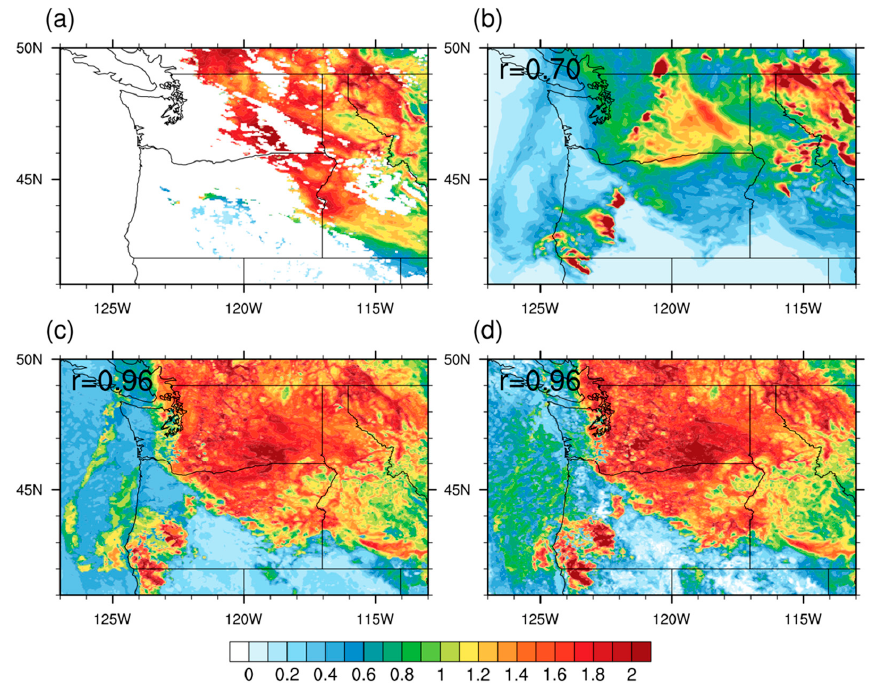
Figure 2. Comparison of the MAIAC AOD at 550 nm and model simulated AOD results at 20:15 UTC (13:15 PDT) on 9 / 7 / 2017. ( a ) the MAIAC AOD product onboard the MODIS Aqua satellite; ( b ) CMAQ simulated AOD; ( c ) bias-adjusted AOD by the RF method; ( d ) same as ( c ) but by the GBM method. The r -values on top-left corners of the subplots (b)–(d) denote spatial correlation coefficients between each model result and corresponding MAIAC AOD product. MAIAC: Multi-Angle Implementation of Atmospheric Correction. AOD: aerosol optical depth. MODIS: Moderate Resolution Imaging Spectroradiometer. CMAQ: Community Multiscale Air Quality model. RF: Random forest. GBM: Generalized boosting